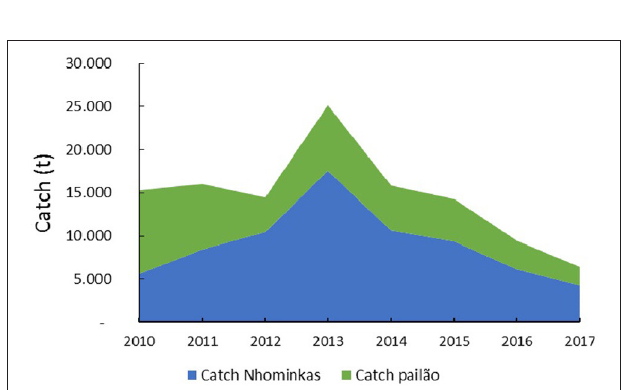
FIGURE 8 | Reconstructed subsistence catches in Guinea Bissau, 2010–2015.